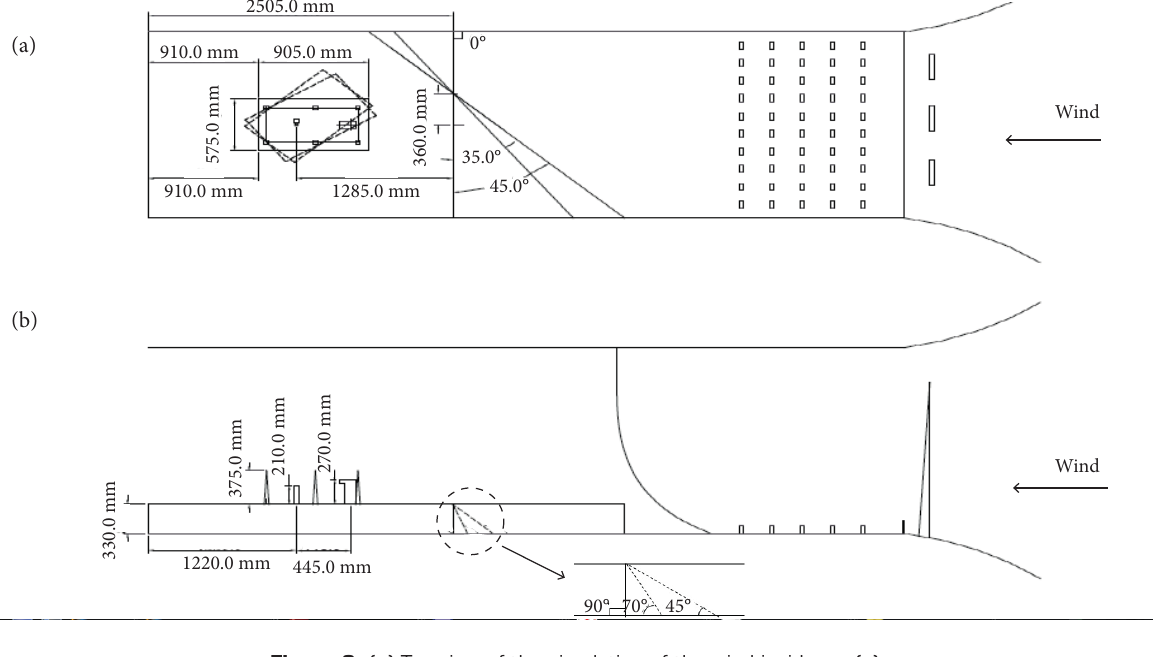
Figure 9. (a) Top view of the simulation of the wind incidence ( α ); (b) Frontal view of the simulation of the coastal cliff inclination ( β